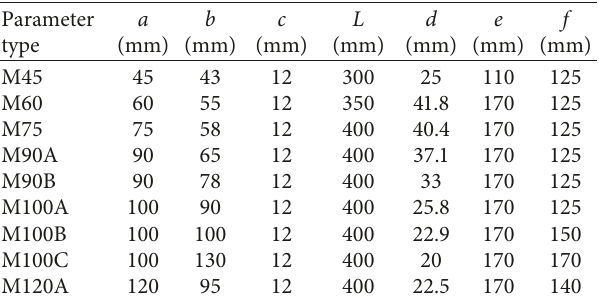
Table 1: Dimension of stub test samples (parameters are shown in Figure